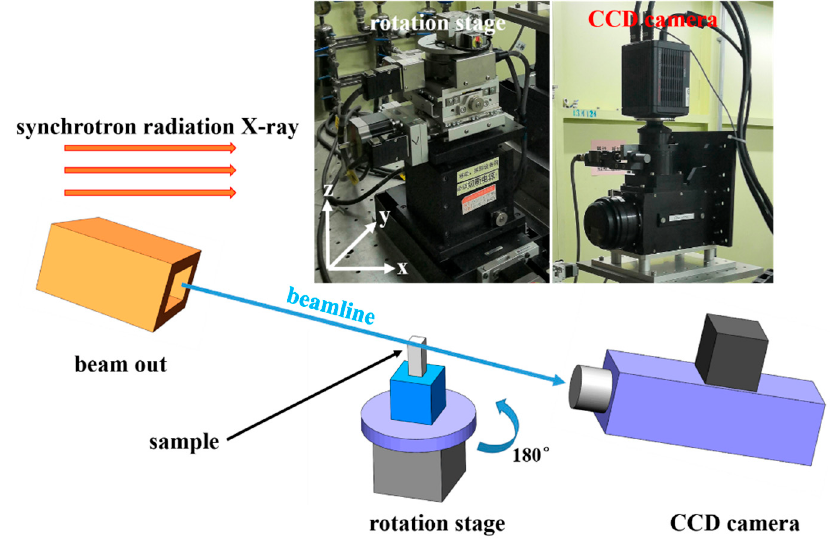
Figure 3. Device schematic of the synchrotron radiation X-ray tomography (SRXT) technique.